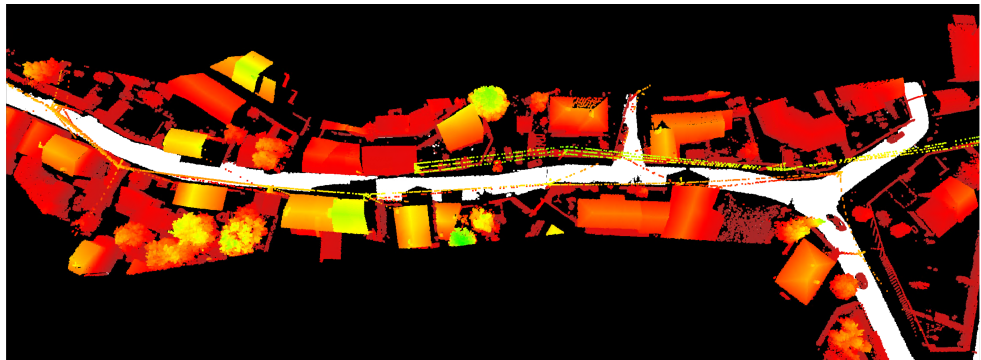
Figure 11. Height above ground in most detailed scale, KNN = 25.